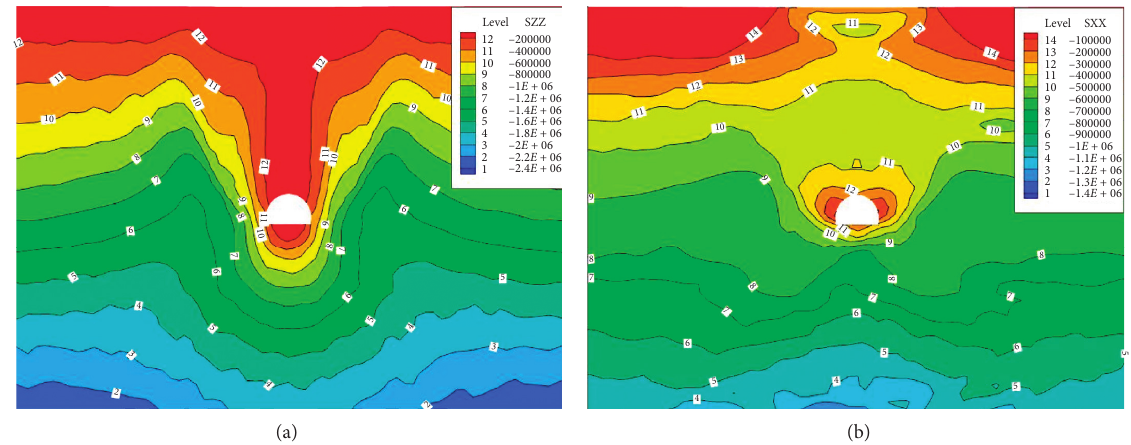
Figure 12: Stress contour of surrounding rock of tunnel under improved support. (a) Contour of ZZ-stress under improved support. (b) Contour of XX-stress under improved